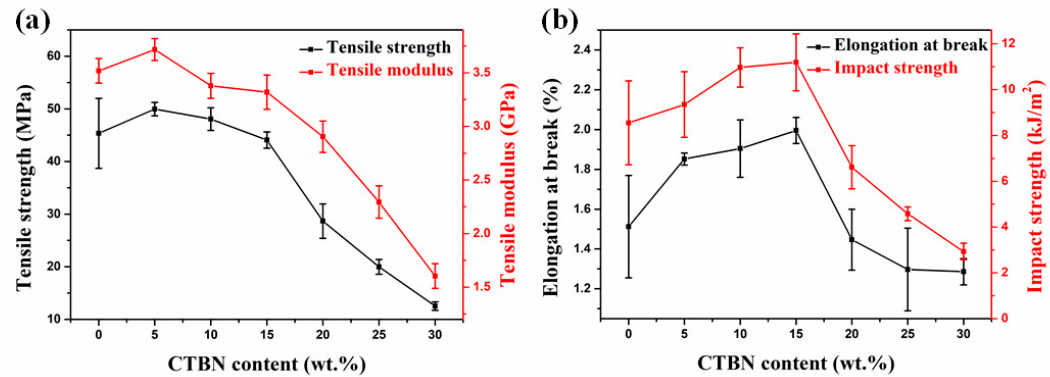
Figure 2. Mechanical properties of composites with different CTBN contents: ( a ) tensile strength and tensile modulus and ( b ) elongation at break and impact strength.